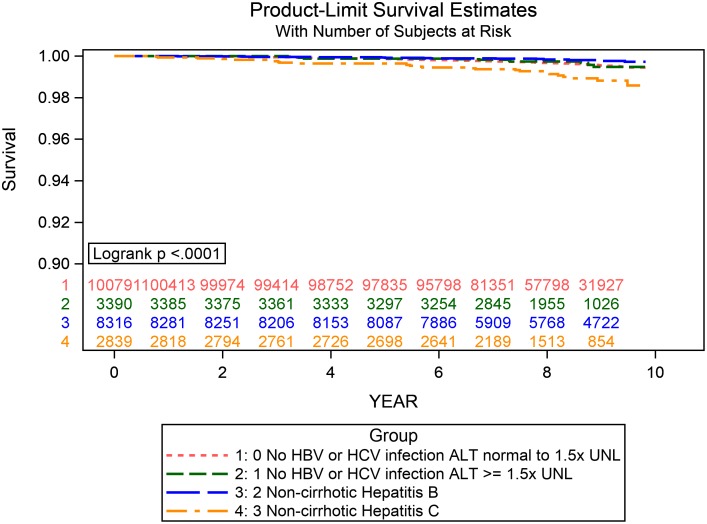
The Kaplan-Myer curves for infection-related mortality in different liver disease categories.The red line (“no HBV or HCV infection ALP normal to 1.5x UNL”) represents NBNC participants with normal to mildly elevated liver enzyme; the green line (“no HBV or HCV infection ALP ≥ 1.5x UNL”) represents NBNC participants with moderate to markedly elevated liver enzyme; the blue line (“non-cirrhotic Hepatitis B”) represents patients with NC-HBV; and the orange line (“non-cirrhotic Hepatitis C”) represents patients with NC-HCV. ALT, alanine aminotransferase; HBV, hepatitis B virus; HCV, hepatitis C virus; UNL, upper normal limit.